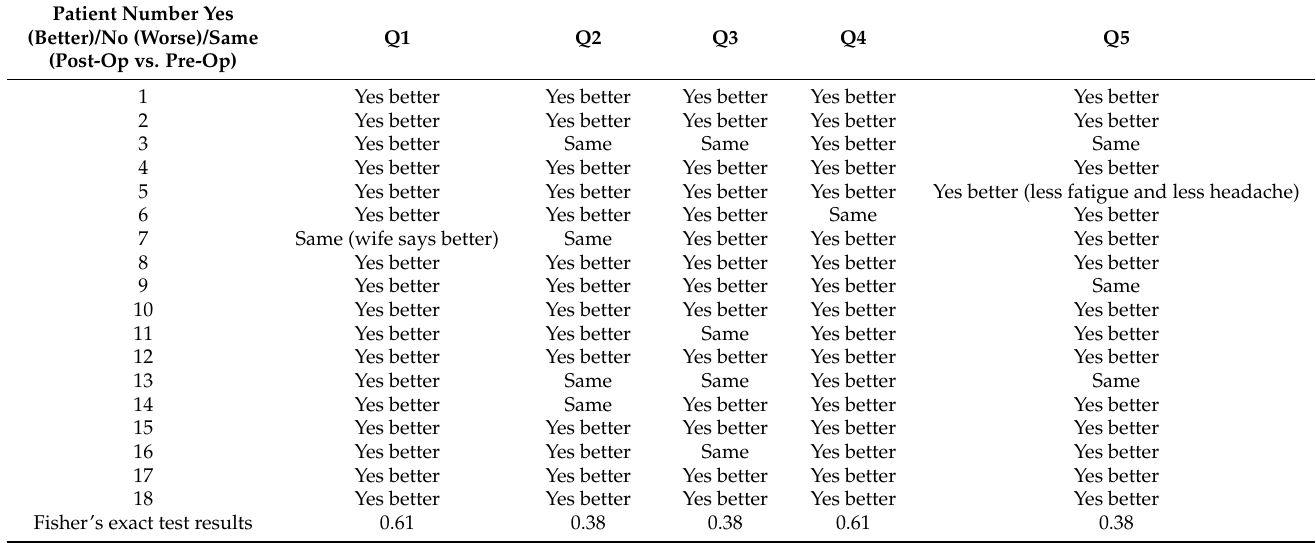
Table 6. QoL questionnaire results evaluating post-operative life